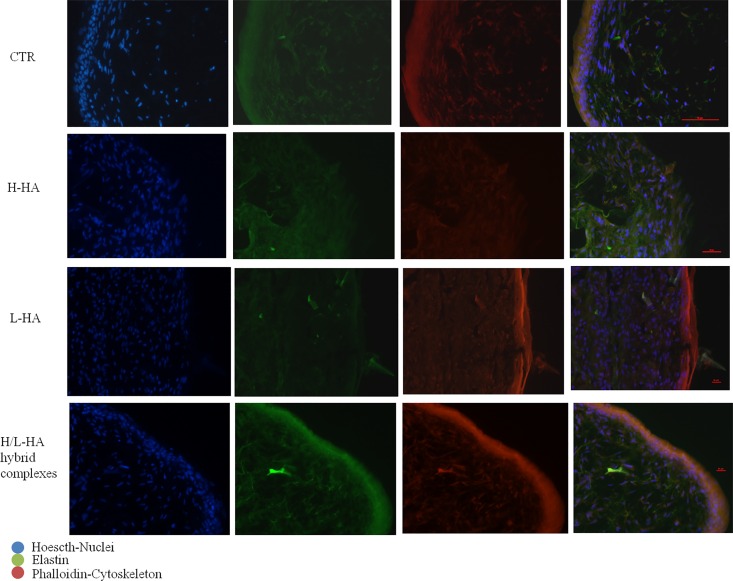
Immunofluorescence pictures relative to ELS expression on FT skin model in presence of H-HA, L-HA and H/L-HA complexes 0.16% (w/w) at 7 days.Blue: Nuclei (Hoescth), Green: ELS, red: Cytoskeleton (Phalloidin).